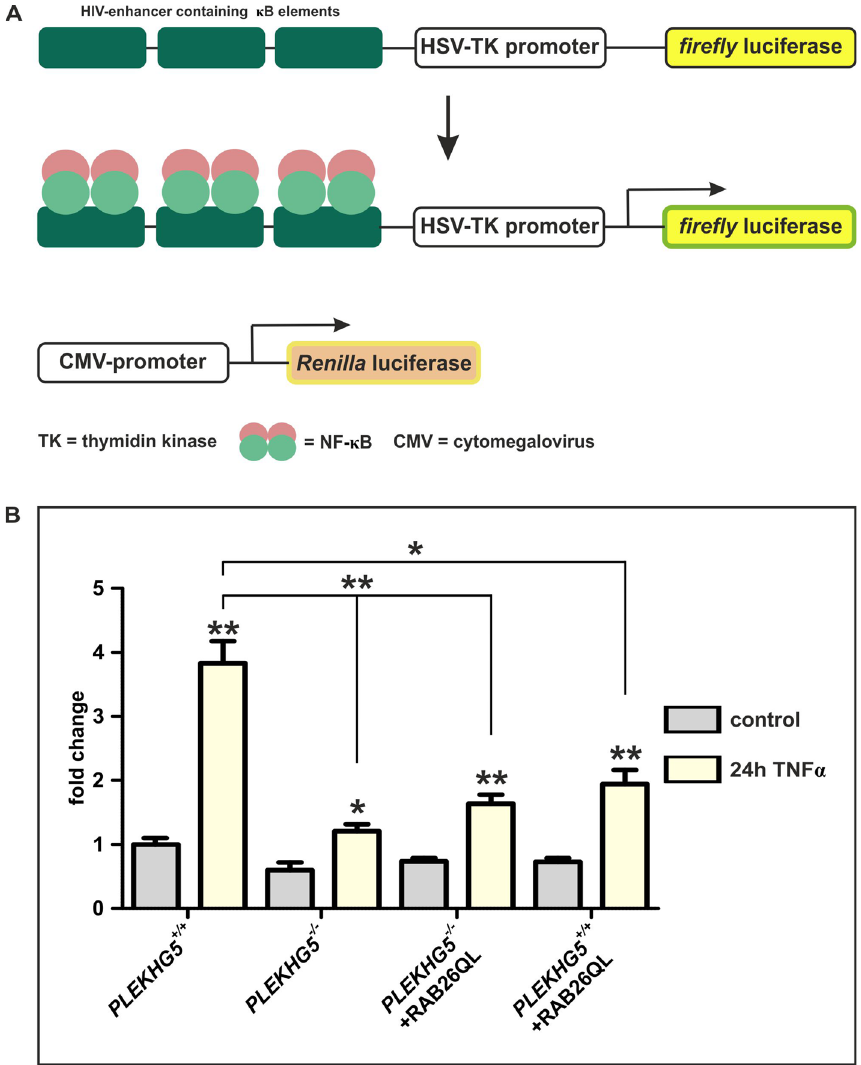
Figure 7. Dual luciferase reporter system revealed strong reduction of NF-κB activity in PLEKHG5-deficient cells after TNFα stimulation. ( A ) Schematic representation of the used NF-κB-reporter system containing TK(NF-κB) 6 LUC vector for detecting NF-κB-activity via firefly luciferase and the constitutively expressing Renilla luciferase vector pRLcmv for normalisation (scheme modified from Greiner et al. 58 ). ( B ) Detection of the NF-κB reporter after 24 h of TNFα treatment showed significantly reduced levels of luciferase activity in PLEKHG5-deficient cells compared to PLEKHG5 wildtype cells. Transduced U251-MG cells also depicted a reduction in the NF-κB activity after TNFα stimulation compared to PLEKHG5 wildtype cells, indicating a more PLEKHG5-dependent regulation as correlated to RAB26. In each cell line, the specific NF-κB activation after TNFα treatment was determined as statistically significant, in comparison to the respective control. Statistical analysis were performed via unpaired, two-tailed t tests (three analysis for each condition and cell line), ** p ≤ 0.01 and * p ≤ 0.05 were considered significant. Mean ±